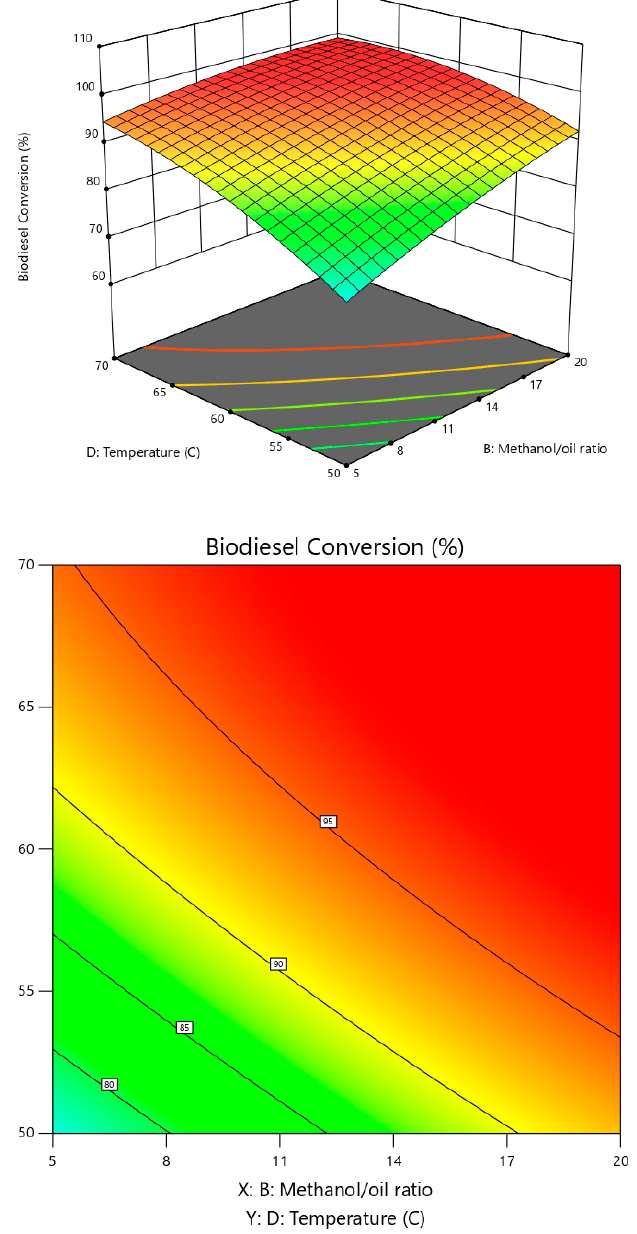
Figure 6. Contour and surface graph representing the relationship between biodiesel conversion, M:O ratio, and reaction temperature.